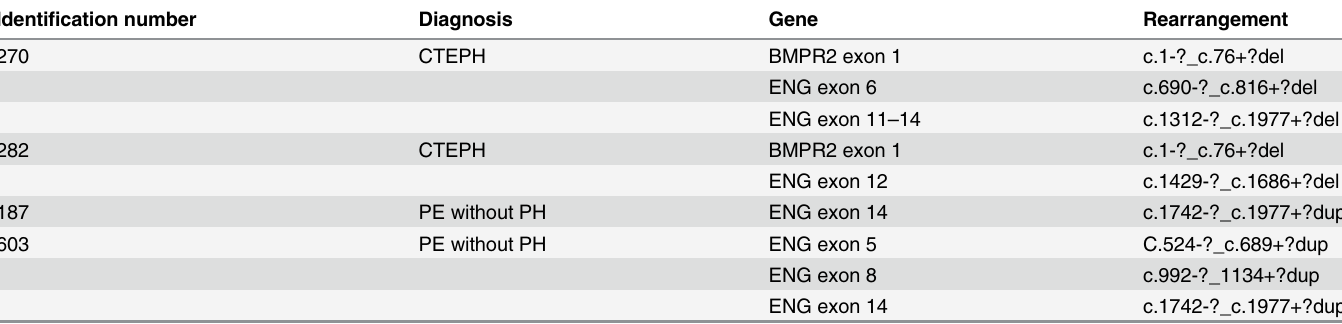
Table 5. Large size rearrangement identified in CTEPH patients and PE without PH patients.